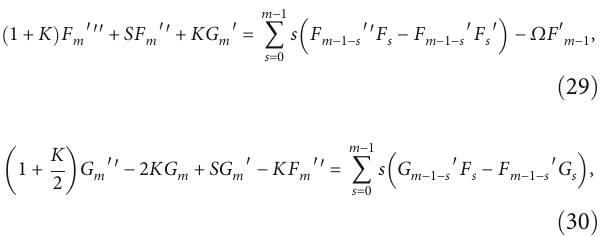
R = 0 : 6, Ω = 0 : 6, andHe = 0 : 2 :